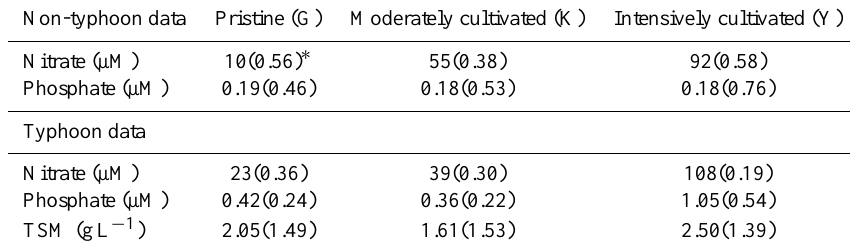
Table 2. The means and coefficients of variation for nitrate, phosphate, and TSM concentration of water samples at three sites, including typhoon and non-typhoon samples. No TSM concentration was measured for non-typhoon samples. Non-typhoon samples were taken twice per week from 2007 to 2008 and typhoon samples were taken during three typhoon periods in 2007. See more detail in the text.